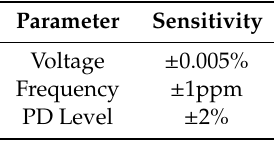
Table 1. Measurement uncertainty ranges of the MPD600 device [27].